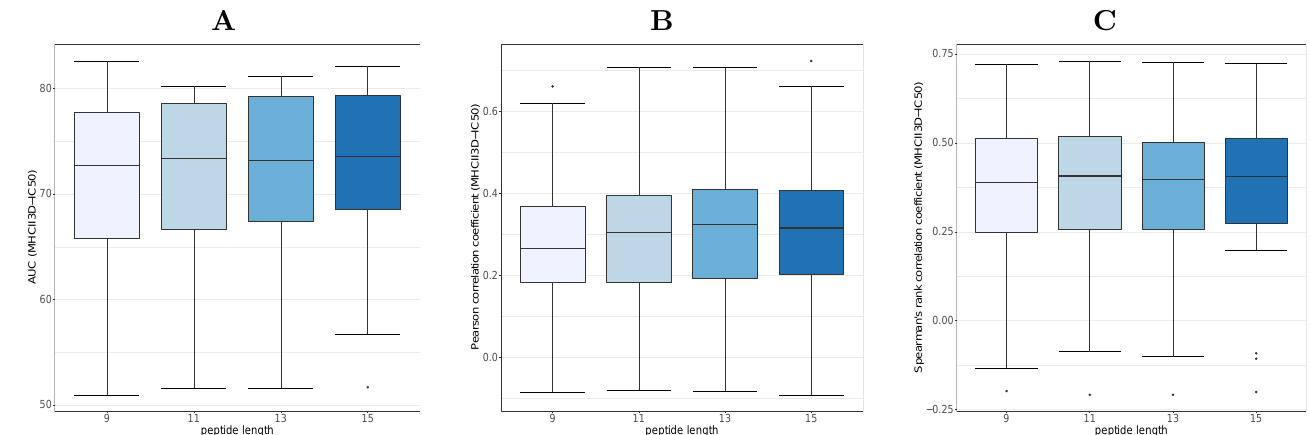
Figure 4. Prediction performance in terms of ( A ) classification (AUC), ( B ) Pearson’s correlation coefficient and ( C ) Spear- man’s rank correlation coefficient for various binding peptide lengths in the MHC II models, grouped by MHC II